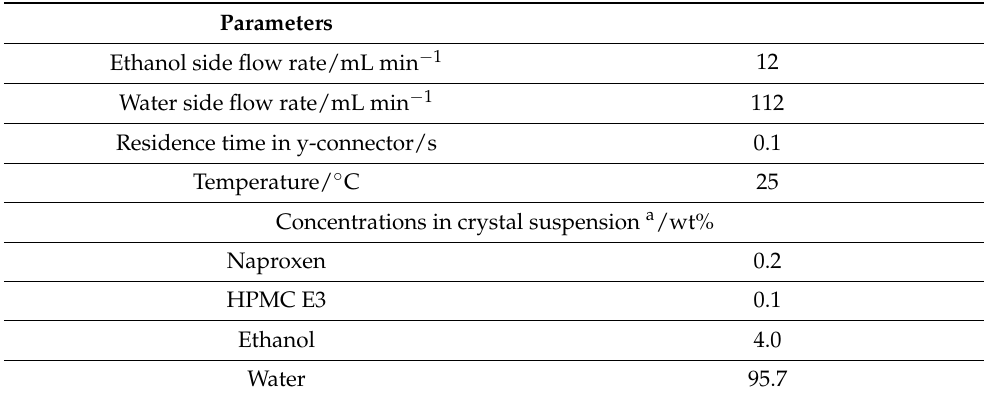
Table 3. Operational parameters for the production of naproxen crystal suspension via solvent/anti- solvent crystallisation and the final composition of the